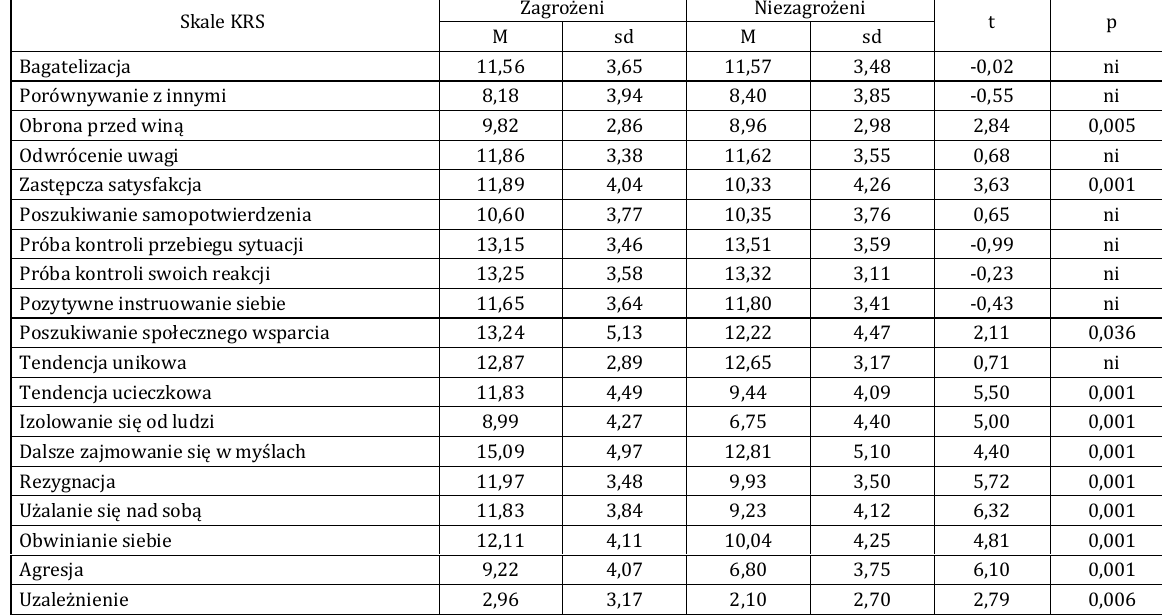
Tabela 1. Porównanie studentów zagrożonych i niezagrożonych uzależnieniem od telefonu komórkowego w zakresie sposobów radzenia sobie ze